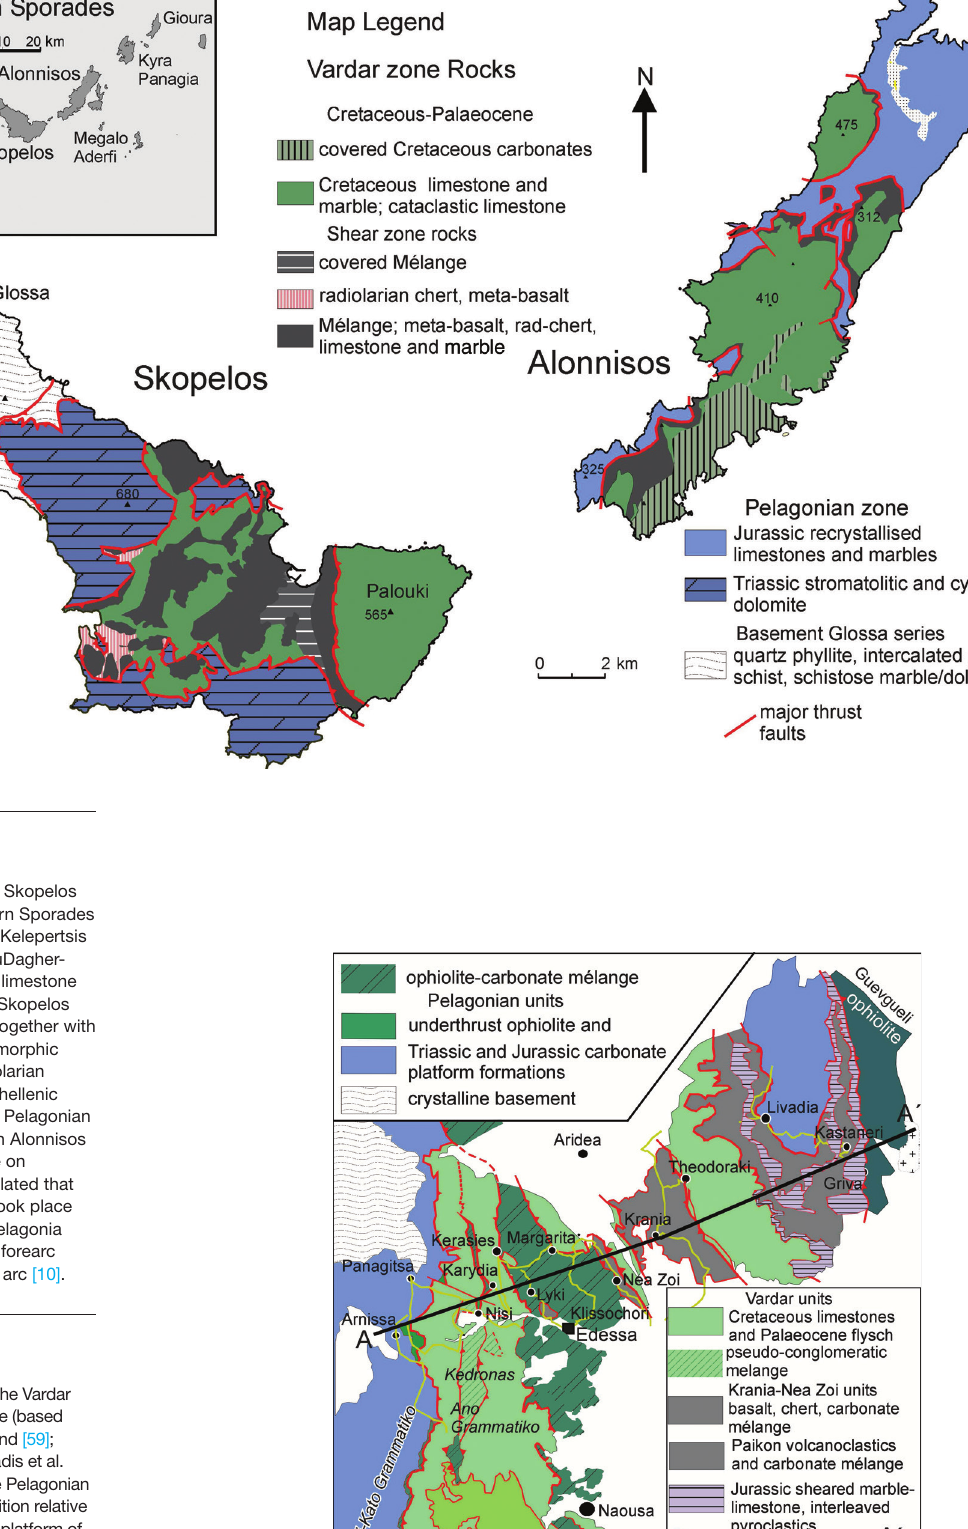
Geological overview map of the Vardar and adjacent Pelagonian zone (based on Mercier and Vergely [55] and [59]; Katrivanos et al. [23]; Georgiadis et al. [56]; and own field work). The Pelagonian zone is in an underthrust position relative to the Cretaceous carbonate platform of the Vardar zone [56] (B–B´). Imbricated ophiolite and Jurassic limestone are exposed in a window extending from Margarita to Veria. Metamorphosed Pelagonian limestone is exposed in the Gandach antiform of the Paikon sub-zone near Livadia. The tectonic section A–A´ is shown in Fig. 4b. The formations between the Gandach marble and the Theodoraki limestone is a composite mélange.